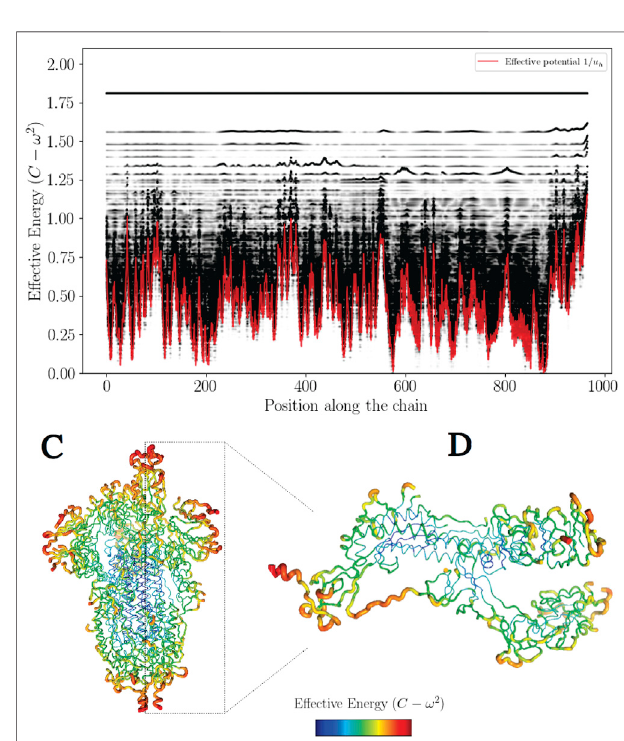
FIGURE 2 | The effective con fi ning potential of high frequencies. The high frequency con fi nement predicted by W h is in agreement with the structureofthedensityofvibrationalstates(here X 2 i )onabandcorresponding to the highest frequencies (A) . 3D representation of W h for the complete protein (S) (B) with a zoom on the fi rst monomer (C)